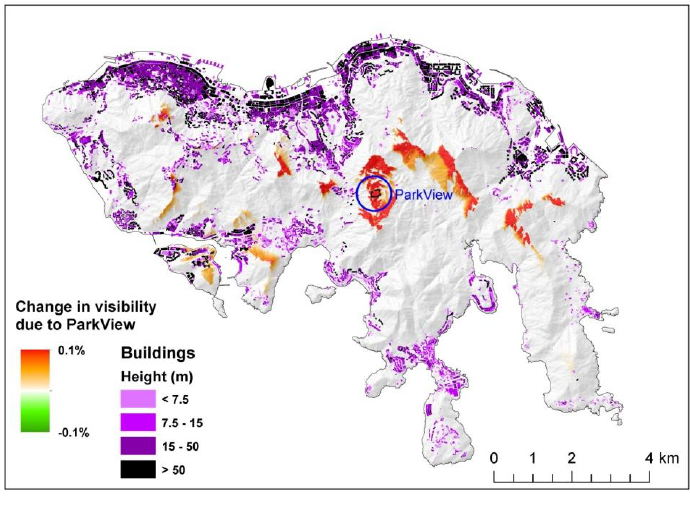
Figure 9. Changes in the visibility resulting from the construction of the Parkview residential project (in the middle of the island, in the blue circle). Areas where visibility of open spaces has decreased due to obstruction by the Parkview residential project are shown in orange-red colours.